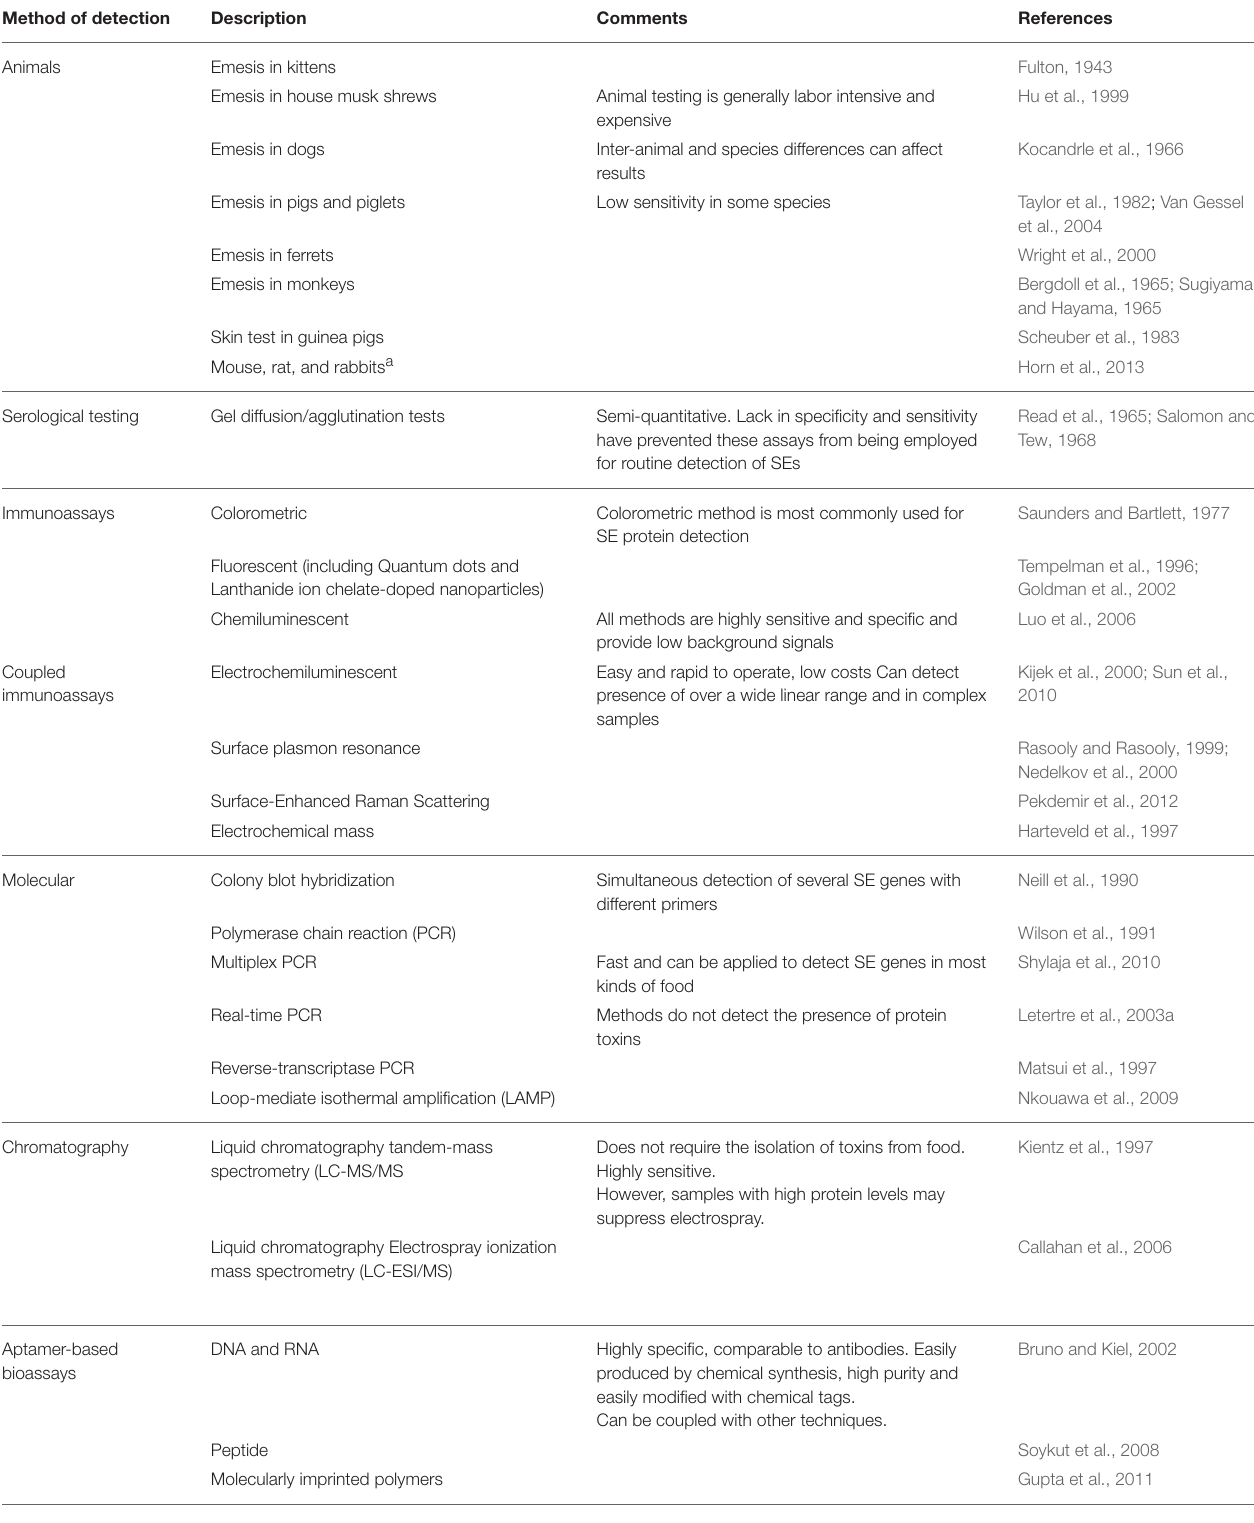
TABLE 2 | A summary of detection strategies for staphylococcal